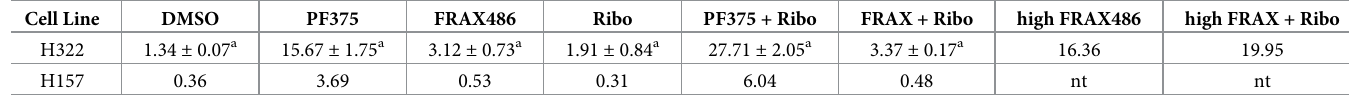
drug addition). The presence of autophagosomes is an indicator of autophagy. Therefore, we measured if we could detect the appearance of autophagosomes on the Celigo, using the Cyto- Table 3. Apoptosis in H322 cells or H157